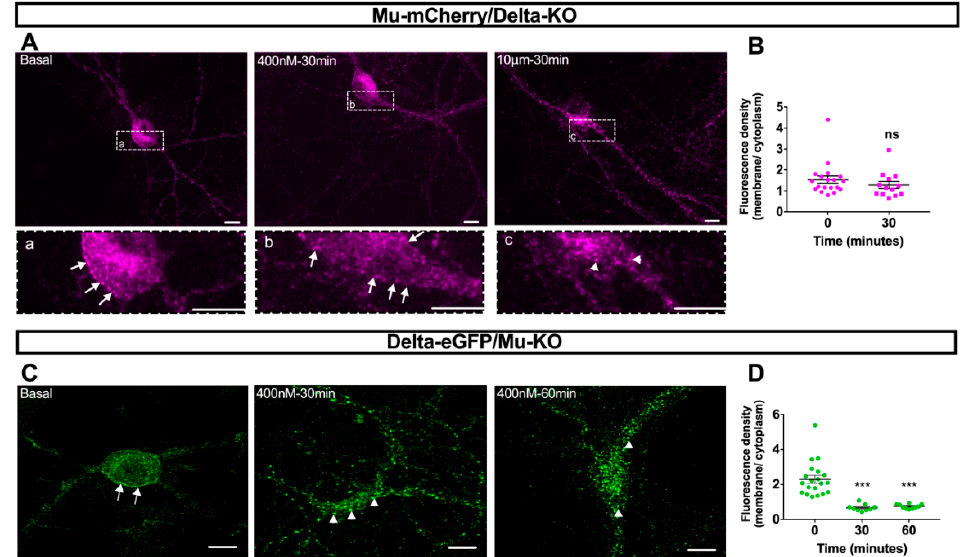
Figure 3. CYM51010 internalization of mu or delta opioid receptors in primary hippocampal cultures from mice deficient for one of the receptors. ( A ) Representative confocal images showing that mu-mCherry is associated with the plasma membrane (arrows) in basal conditions and 30 min after CYM51010 (400 nM) addition in delta-knockout (KO) mice. Scale bar = 10 µ m. ( B ) Mu-mCherry internalization induced by CYM51010 application expressed as a ratio of membrane-associated versus intracellular fluorescence densities. Mann–Whitney test, p = 0.20; n = 13 to 20 neurons per group from at least three independent cultures. ( C ) Representative confocal images showing that delta-eGFP is predominantly associated with the plasma membrane in basal conditions (arrows) in mu-KO mice, whereas the association is mostly intracellular at 30 and 60 min after CYM51010 (400 nM) addition (arrowheads). Scale bar = 10 µ m. ( D ) Delta-eGFP internalization induced by CYM51010 application expressed as a ratio of membrane-associated versus intracellular fluorescence densities. Kruskal–Wallis test ( p < 0.0001) followed by Dunn’s multiple comparison test. Significant differences after multiple-comparison tests are expressed as p < 0.001 (***) compared to basal group; n = 9–20 neurons per group from at least three independent cultures.